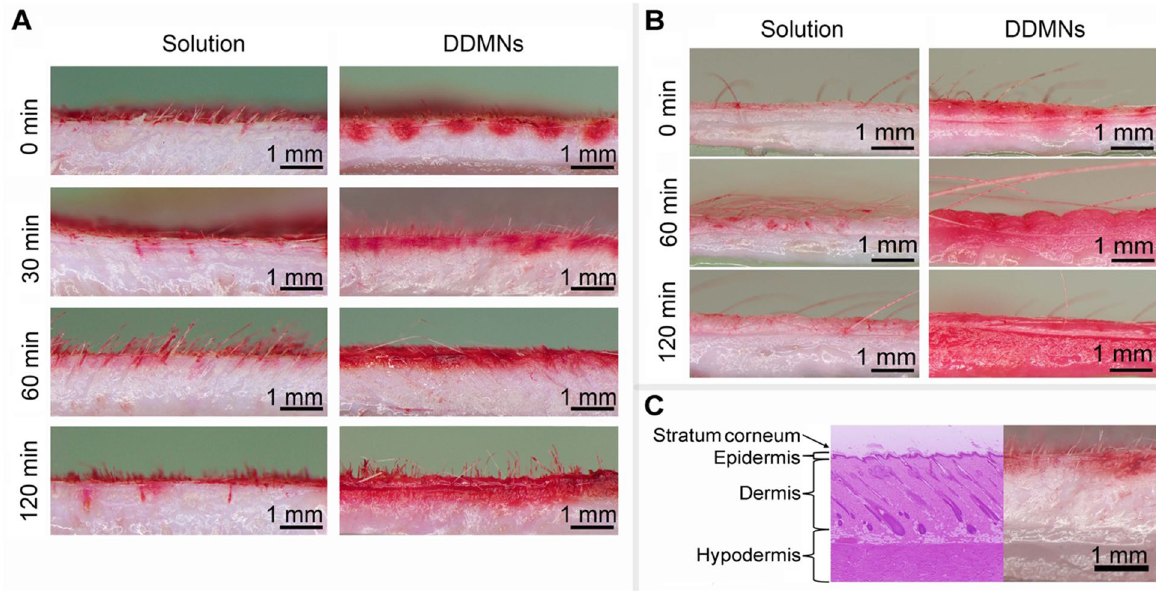
Figure 2. Stereomicroscopic images of cross sectioned skin tissues at defined times (denoted at the left side of each row) after the topical administration of red dye solution at 470 µg dye on circular area of 1.5 cm diameter of the skin (left cloumn of ( A,B )) and red dye-loaded DDMNs (containing 470 µg dye in circular patch of 1.5 cm diameter, 550 µm needle length) (right column of ( A,B )) for the rat back skin ( A ) and pig ear skin ( B ). Figure ( C ) shows layers of rat